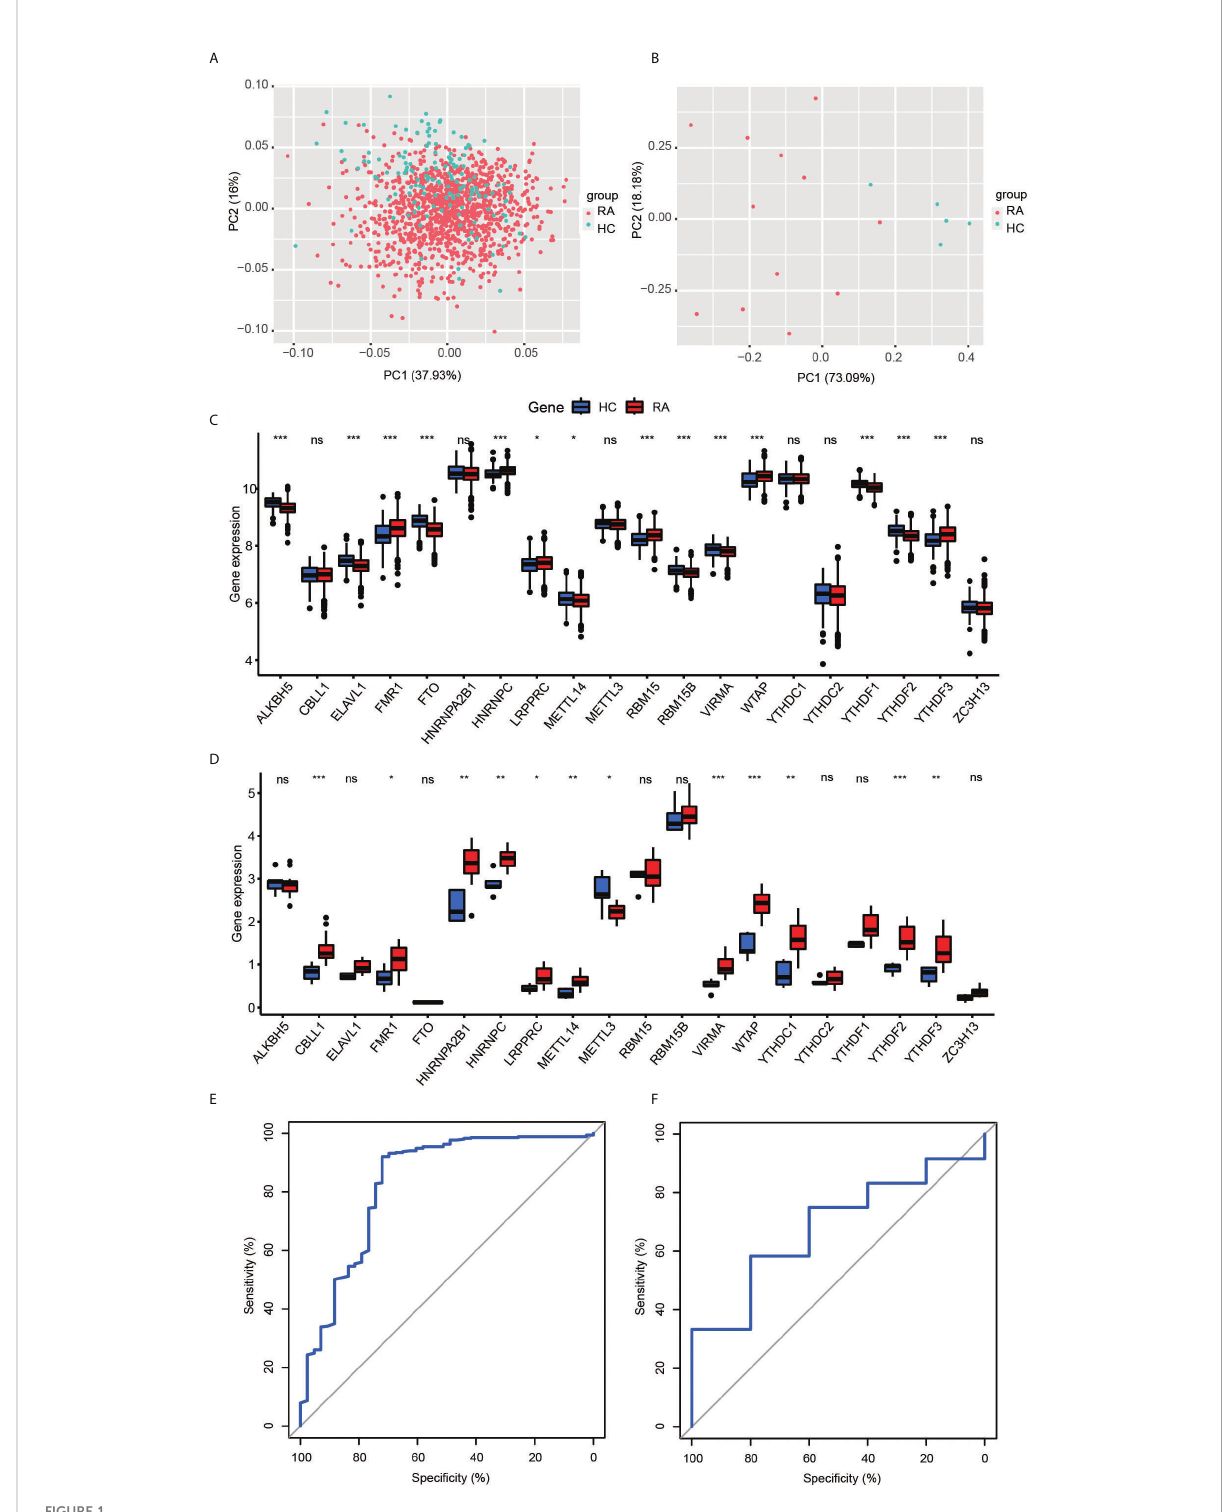
FIGURE 1 (A, B) Principal component analysis for the expression pro fi les of 20 m6A regulators could roughly distinguish RA from HC samples in the GEO cohort (A) and validation cohort (B) . (C, D) The box plot demonstrated the 20 m6A regulators between healthy and RA patients in the GEO cohort (C) and clinical validation cohort (D) (*P < 0.05, **P < 0.01, ***P < 0.001, ns P >=0.05). (E, F) ROC curve of the 20 speci fi cally expressed m6a regulators in RA samples. The 20-M6A feature random forest model predicted the testing cohort (E, AUC = 0.83) and validation cohort (F, AUC =